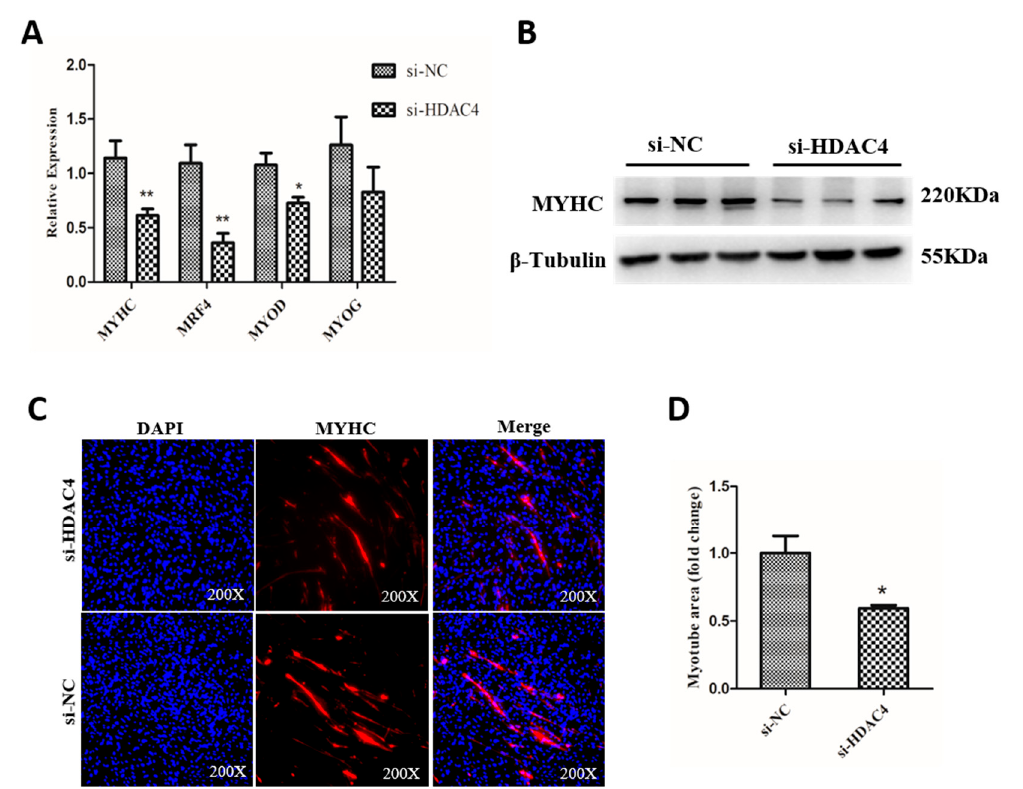
Figure 4. Knockdown of HDAC4 inhibits the differentiation of chicken SMSCs. ( A ) The mRNA level of MYHC, MRF4, MYOD1, and MYOG was determined by qPCR in SMSCs after being transfected with si-HDAC4 and si-NC. ( B ) The protein expression level of MYHC was determined by western blotting in SMSCs after being transfected with si-HDAC4 and si-NC. ( C ) SMSCs transfected with si-HDAC4 and si-NC induced to differentiate for 72 h were stained with MYHC antibody and DAPI (nuclei). All photomicrographs are at 200 × magnification. ( D ) The percentage of myotube area to total cell area was calculated at 72 h after transfection of si-HDAC4 and si-NC. In all panels, the values represent mean ± SEM from three independent experiments. * p < 0.05; ** p < 0.01.